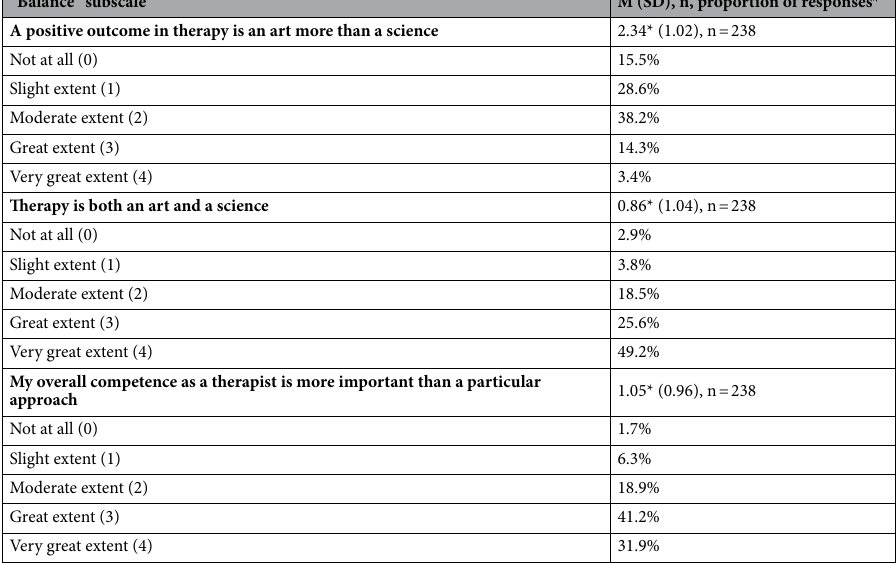
Table 3. EBPAS-36 “Balance” subscale. * Reversed ratings; a higher value indicates a more positive attitude toward EBP. Abbreviations: EBP = evidence-based practice, EBPAS-36 = Evidence-Based Practice Attitude Scale-36, M = mean, n = number of respondents, SD = standard